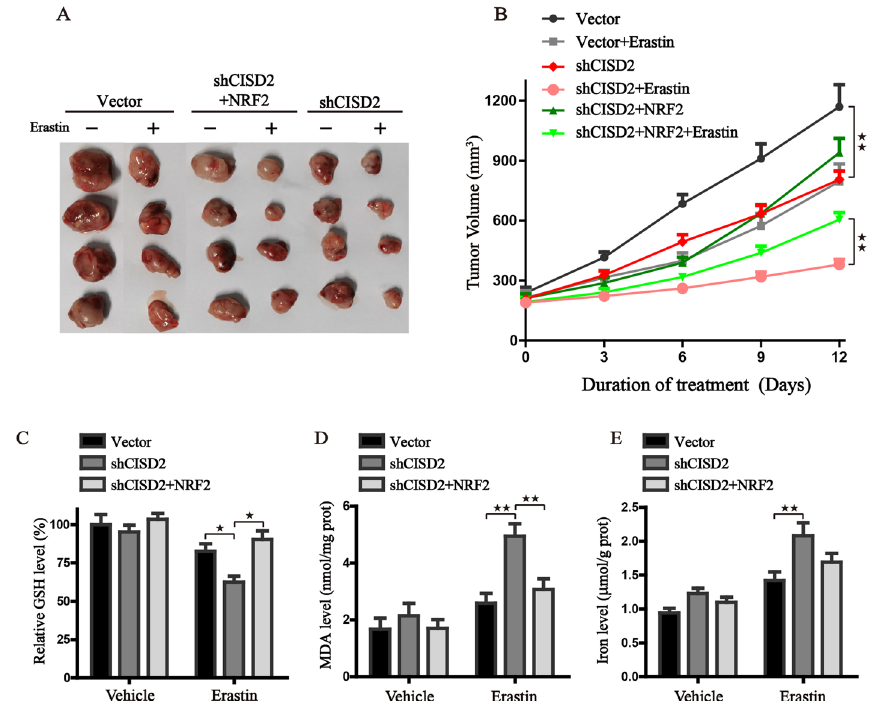
Fig. 5 NRF2 overexpression promotes the growth of xenografts via enhancing antioxidation. A The gross morphology of subcutaneous tumors in nude mice of each indicated group. B The curves of time-dependent tumor volume after the injection of Erastin. C – E Detection of the GSH, MDA, and iron content, respectively, in tumor tissues from each group; protein concentration was used for calibration. ★ P < 0.05 and ★★ P < 0.01 between the indicated